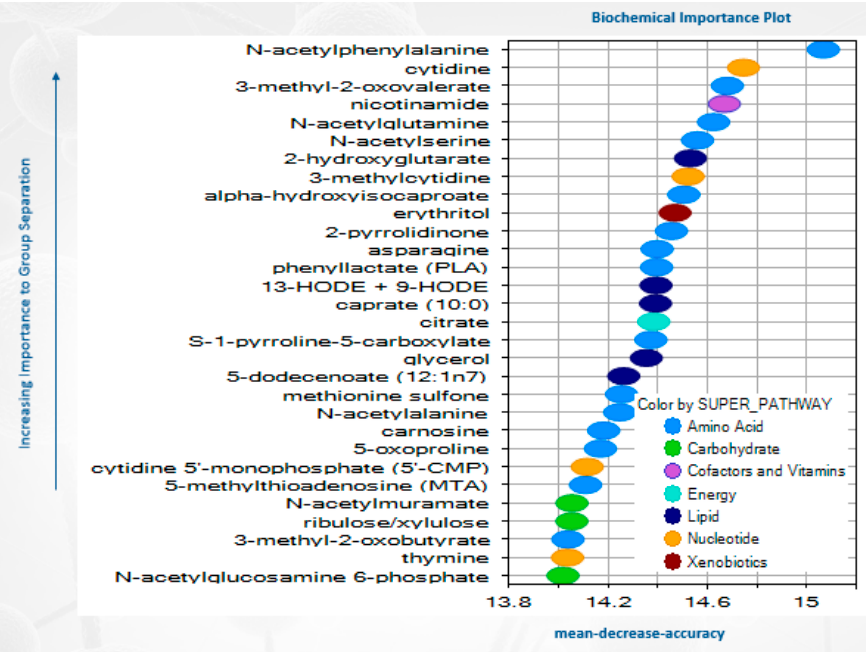
Figure 4. Random forest analysis showing biochemical profiles for the different samples were highly successful in binning the samples to their appropriate groups.